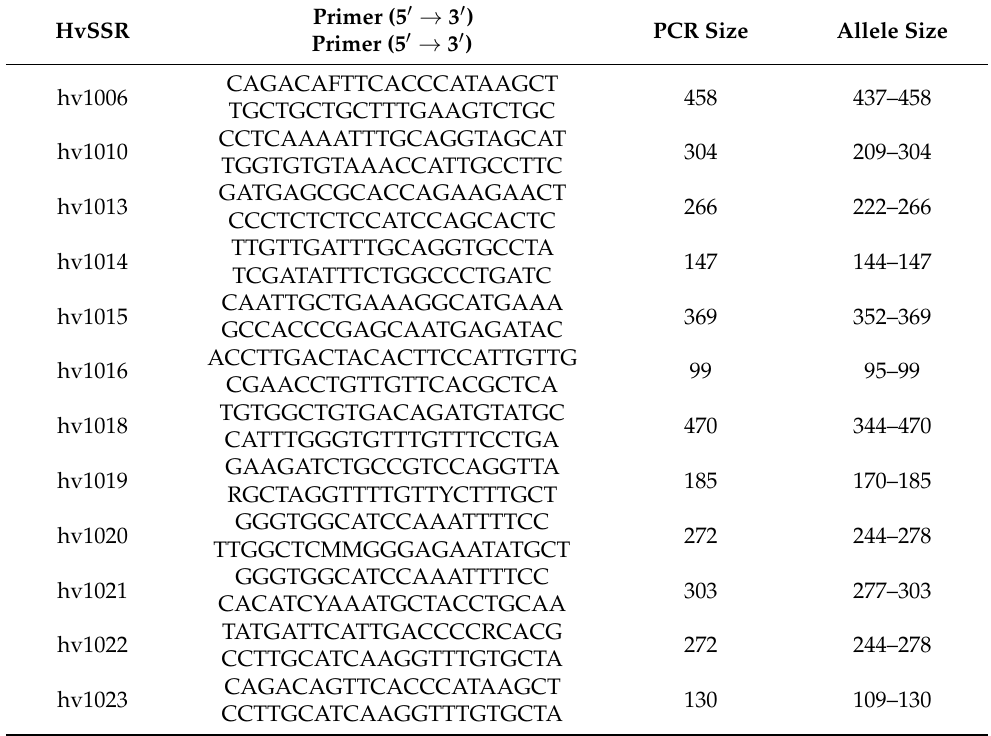
Table 1. Primer sequences of the SSR